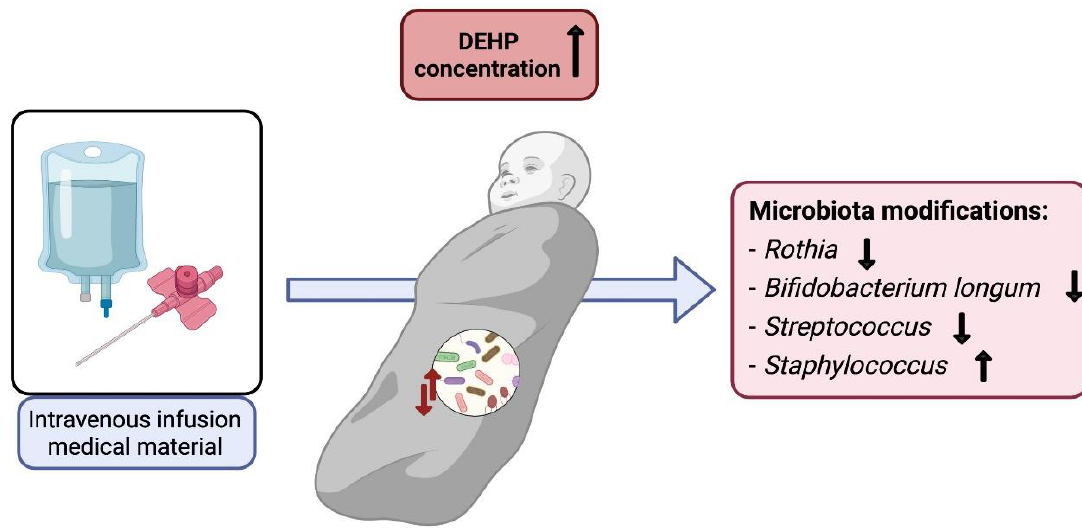
Figure 4. DEHP exposure and microbiota modifications in